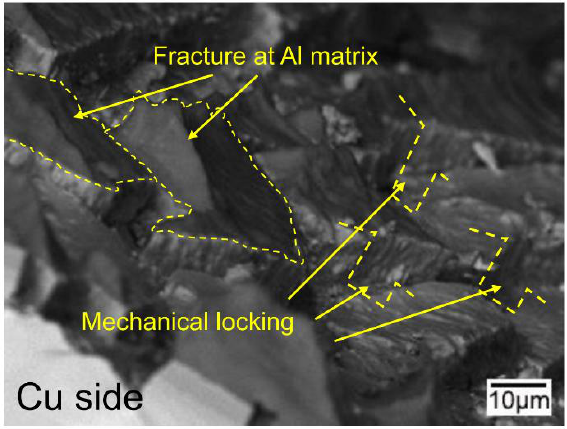
Figure 15. Peeled surface morphology (BSE image) of the Cu/Al clad sheet with a thickness of 7 mm after multi-pass rolling (Cu side). after multi-pass rolling (Cu side). after multi-pass rolling (Cu side).